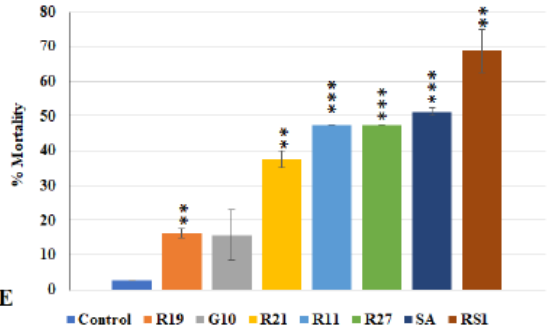
Figure 5. Development and viability of Drosophila larvae exposed to VOCs emitted by Penicillium species. The percentages of living larvae ( A ), pupae ( B ), living adults ( C ), and dead flies ( D , E ) are shown. Asterisks (*) indicate significant difference from control (* p < 0.05, ** p < 0.005, *** p < 0.0005). NS denotes not significant, and N = 90. Dashed vertical lines denote the days for statistical analyses. R19, R21, R11, and R27 are P . expansum species isolated from apple; P. crustosum G10 and P. polonicum RS1, P . solitum SA are species isolated from apple and peach seed, respectively.